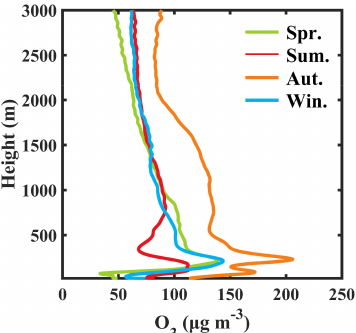
Figure 5. Seasonally averaged vertical distribution of O 3 con- centrations at the Dongguan superstation from the surface to an altitude of 3000m in 2019. Spring (Spr.): March–May, Summer (Sum.): June–August, Autumn (Aut.): September–November, Win- ter (Win.):